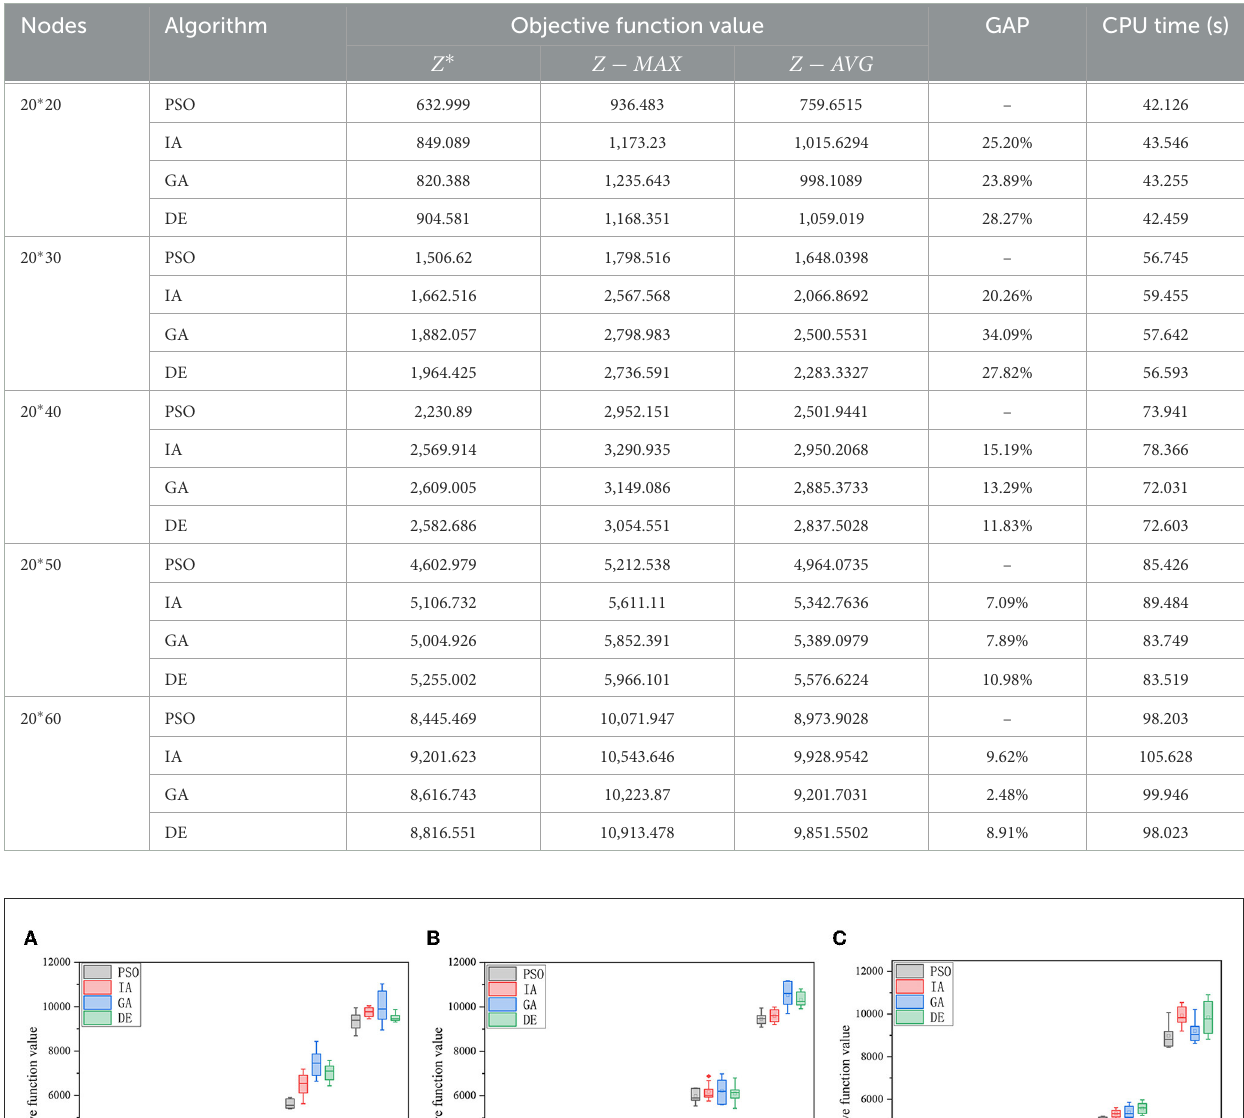
TABLE 8 Scale analysis of the group 3.